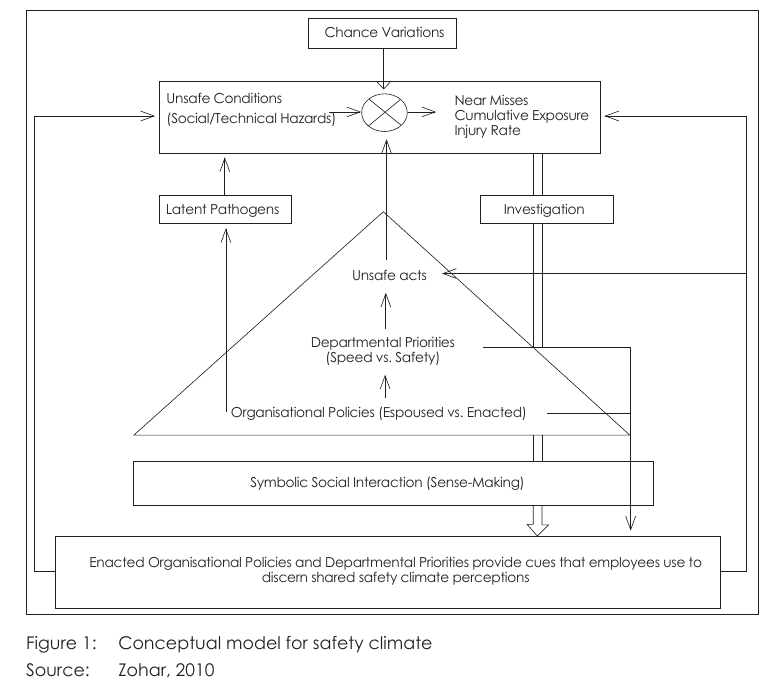
Figure 1: Conceptual model for safety